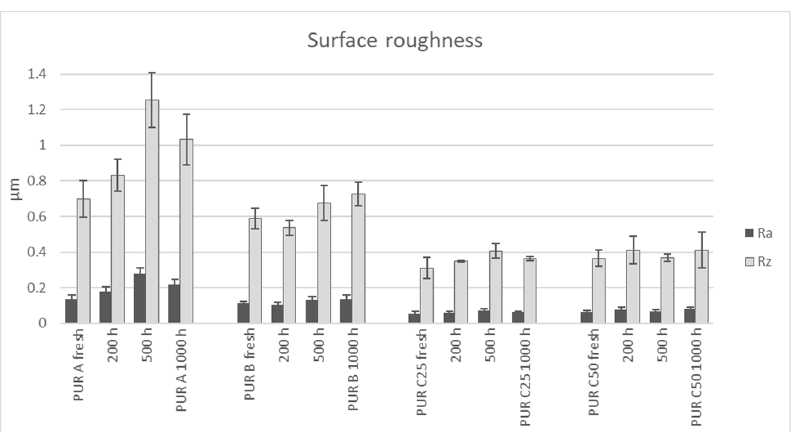
Figure 3. Roughness values R a and R z for fresh and UV(B)-aged coating surfaces (durations as indicated), representing the mean of 18 single measurements and the resulting standard deviations.